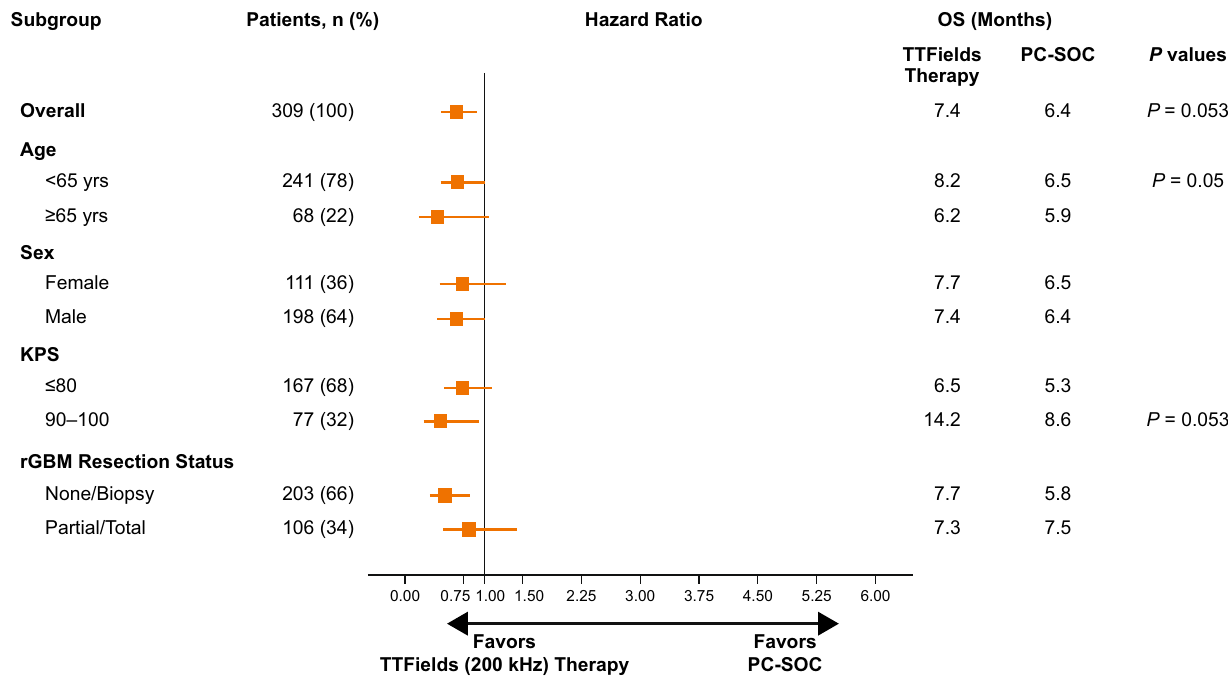
Fig. 2 Cox hazard ratios of OS by prognostic factor subgroups in EF-19 registry of TTFields therapy (N = 192) and PC-SOC (N = 117) in ITT population for patients with rGBM. Symbols represent Cox HRs in each subgroup of patients treated with TTFields therapy in EF-19 registry compared to PC-SOC arm (EF-11 clinical study control group), while adjusting for other prognostic factors. Whiskers represent the 95% CIs of the HR. CI, confidence interval; HR, hazard ratio; KPS, Karnofsky Performance Status score; OS, median overall survival; PC-SOC, physicians’ choice standard of care; rGBM, recurrent glioblastoma; TTFields, Tumor Treating